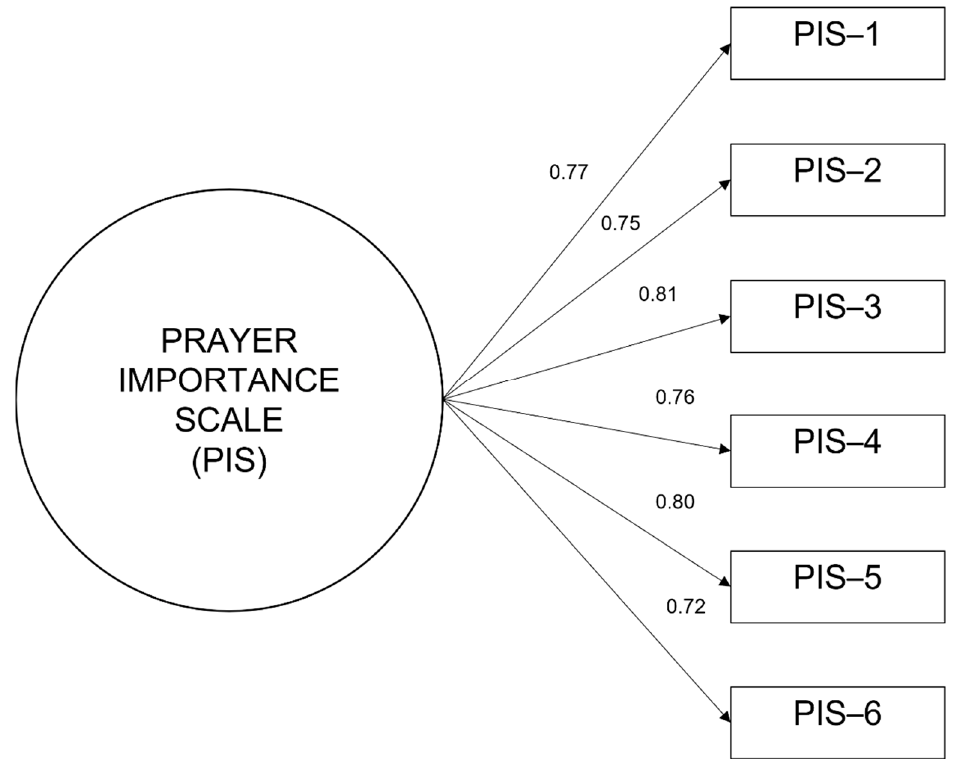
Figure 1. ESEM of PIS (regression weights)—study 1. Source: own elaboration. All test items were found to correlate at a very high level with the latent variable, prayer importance. Model fit indices were observed to partially explain model fit. CFI